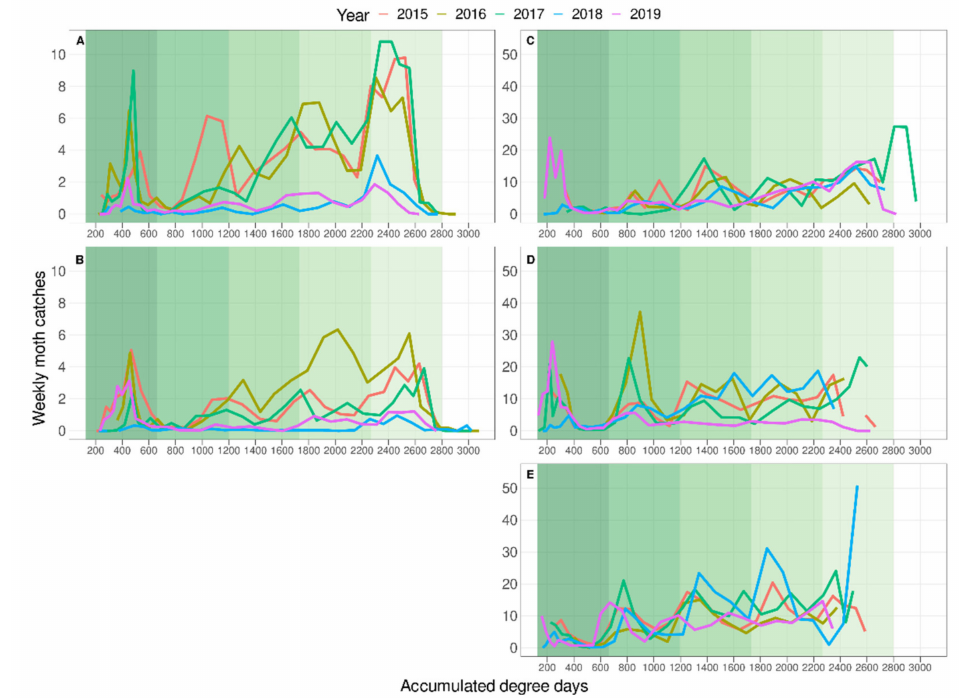
Figure 3. Mean weekly moth catches plotted against accumulated DD for each year (2015–2019) and for each area. ( A ) Alt Empord à and ( B ) Baix Empord à , both of Girona province; and ( C ) Stone area, ( D ) Mixed area and ( E ) Pome area, the three of the Lleida province. Background colours indicate the predicted generation range of the phenology model (535 DD) [18]. Note: the y -axis scale is different for AB than for CDE.